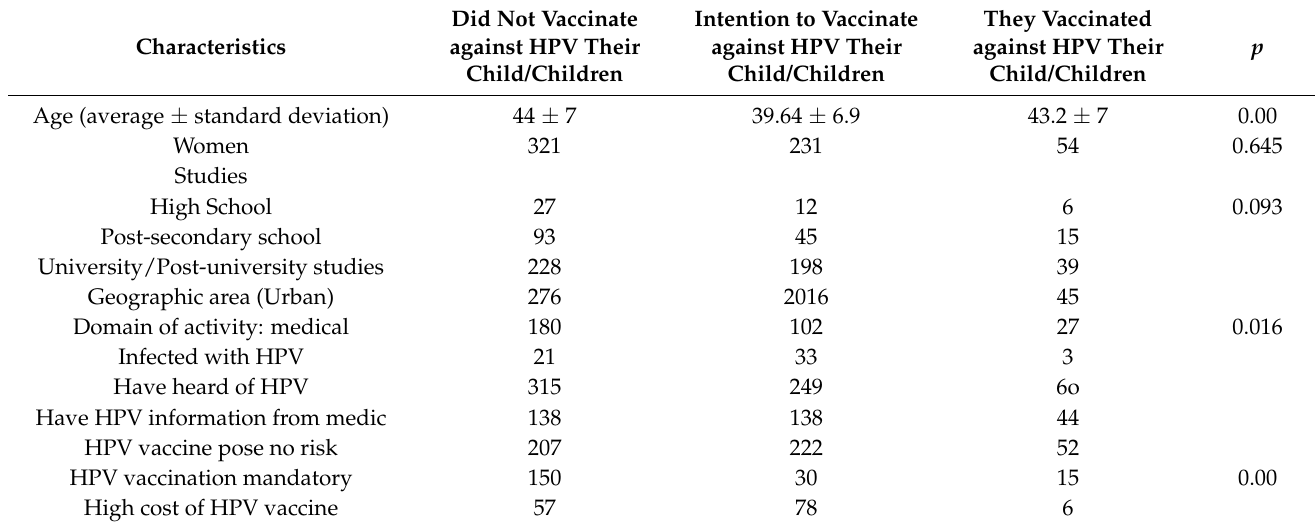
Table 2. Infectious HPV status, socio-demographic and educational characteristics of the 666 Roma- nian parents according to HPV vaccination and intention to vaccinate their